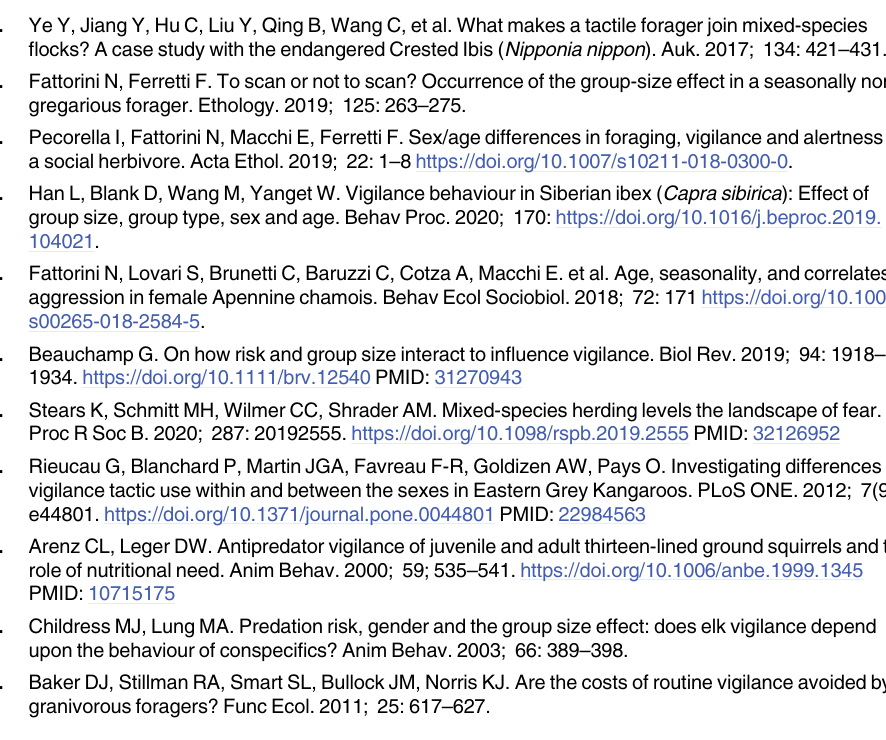
S1 Table. Data about